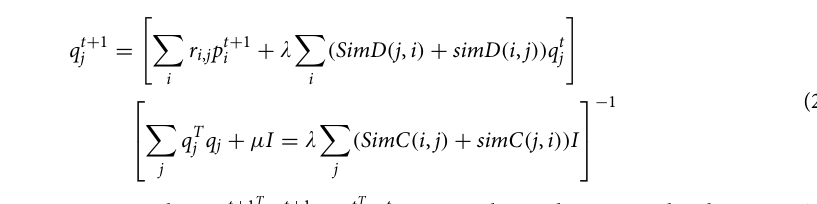
Figure 9. The pseudo-code for evaluation of ADRML